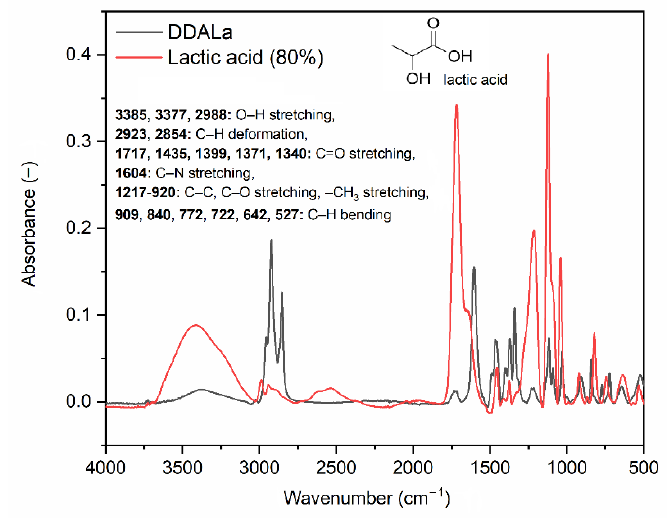
Figure 6. Fourier Transform Infrared Spectroscopy (FTIR) spectra for DDALa and lactic acid— identification of bands characteristic for lactate anion of DDALa.